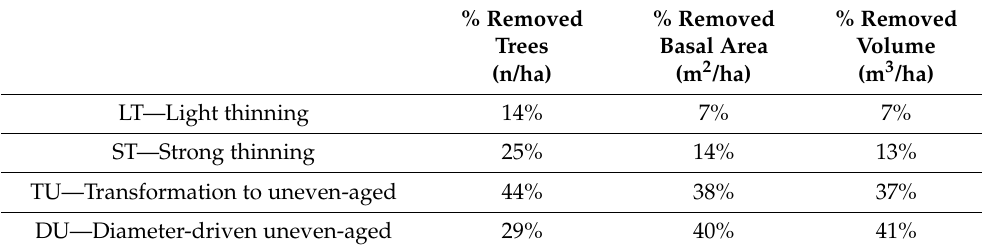
Table 1. Fellings in number of trees, basal area, and volume by type of treatment in 2009.